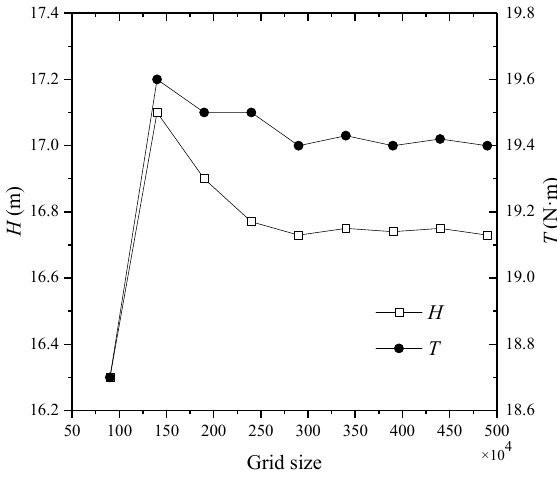
Figure 3. Grid independence analysis. Table 2. Turbulence model independence verification ( Q = 1.0 Q d ).